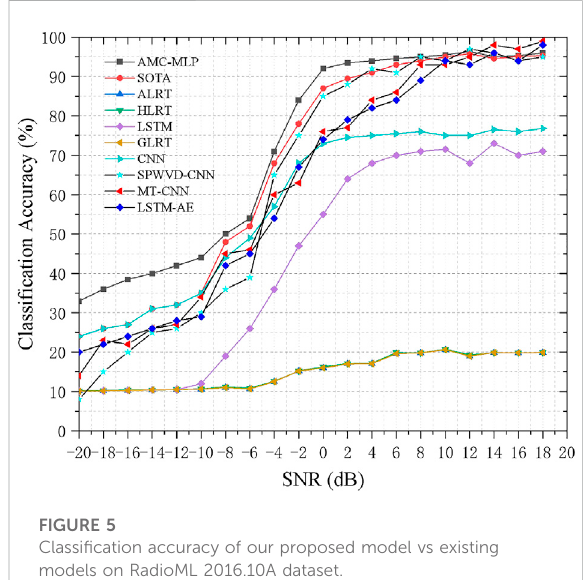
FIGURE 5 Classi fi cation accuracy of our proposed model vs existing models on RadioML 2016.10A